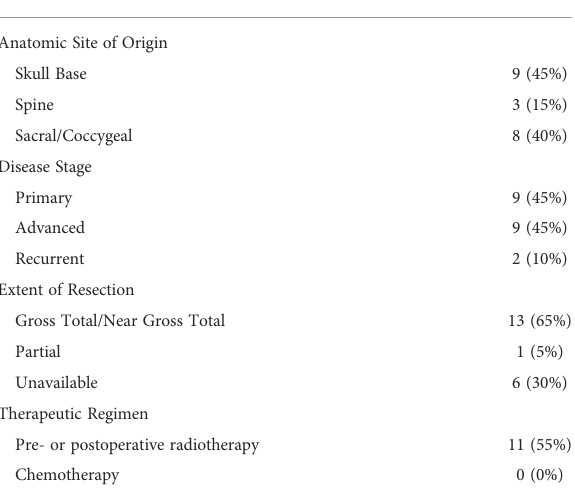
TABLE 1 Patient Clinical